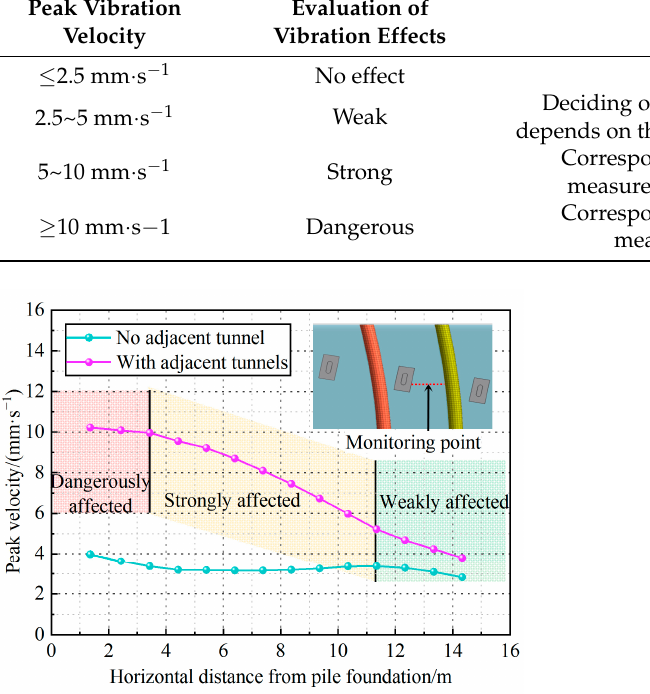
Figure 11. Evaluation of dynamic response under moving train loads.